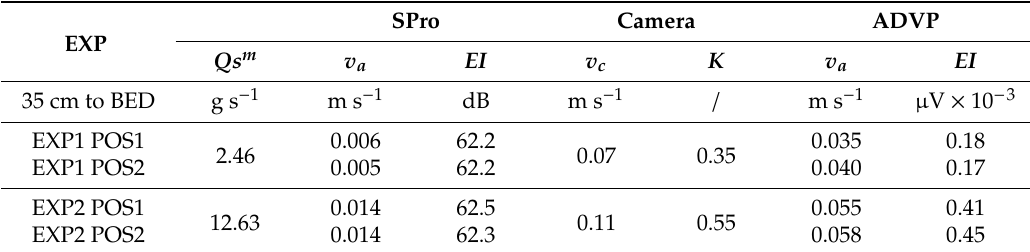
Table 3. Average bedload data measured at two positions in the UniBo flume, Qs m is the sediment transport rate measured by a bedload